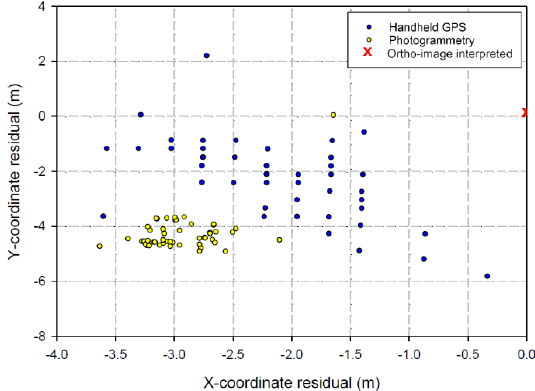
Figure 4. Comparison between handheld GPS and mobile photogrammetric tree X and Y coordinates relative to the orthoimage-interpreted stem positions for the windbreak site.